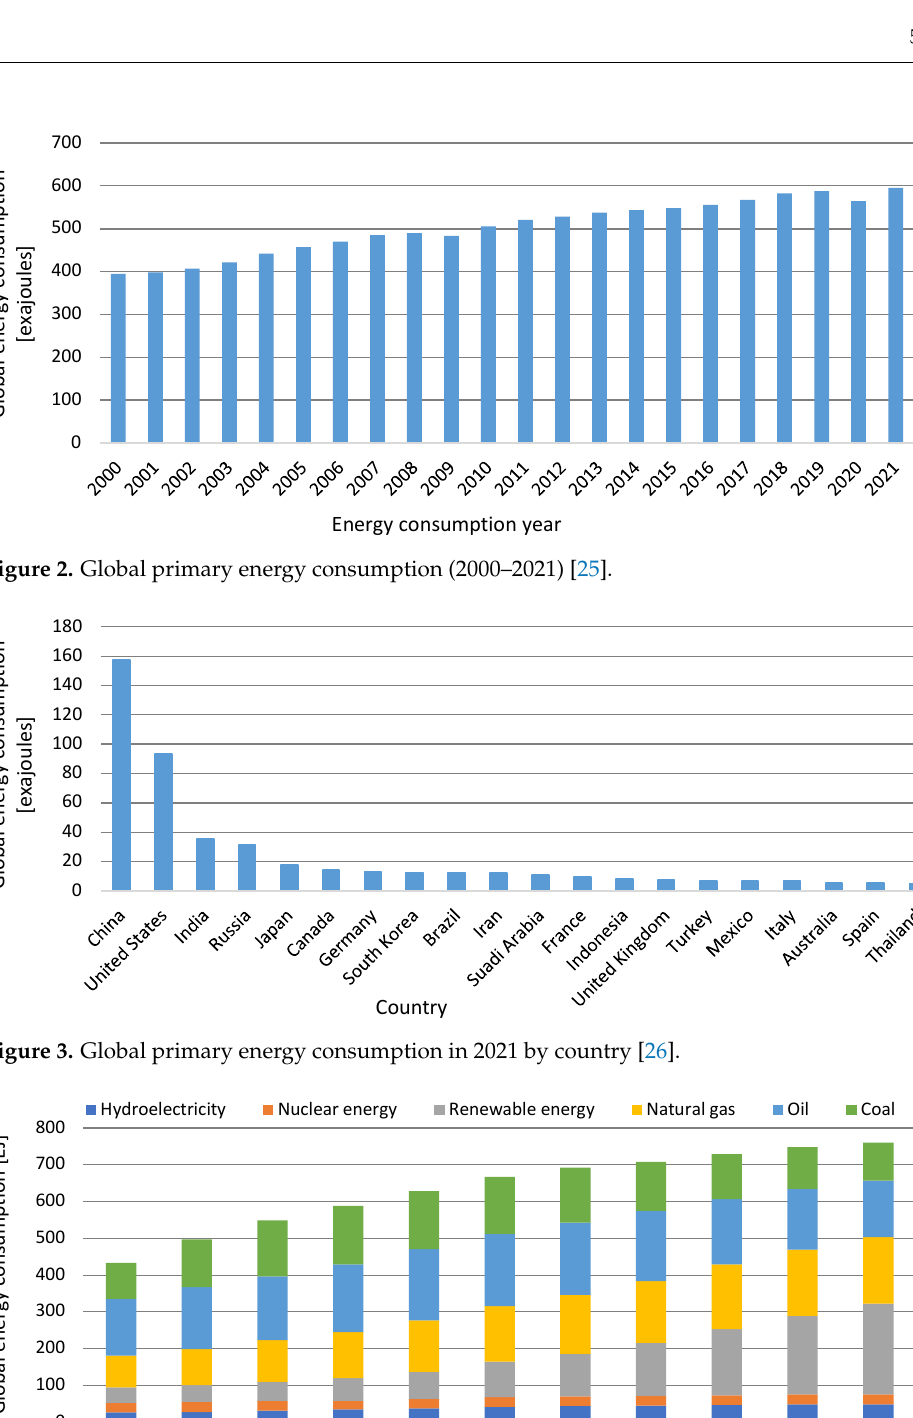
Figure 4. Global energy consumption (2000–2019) and a forecast until 2050 [27].